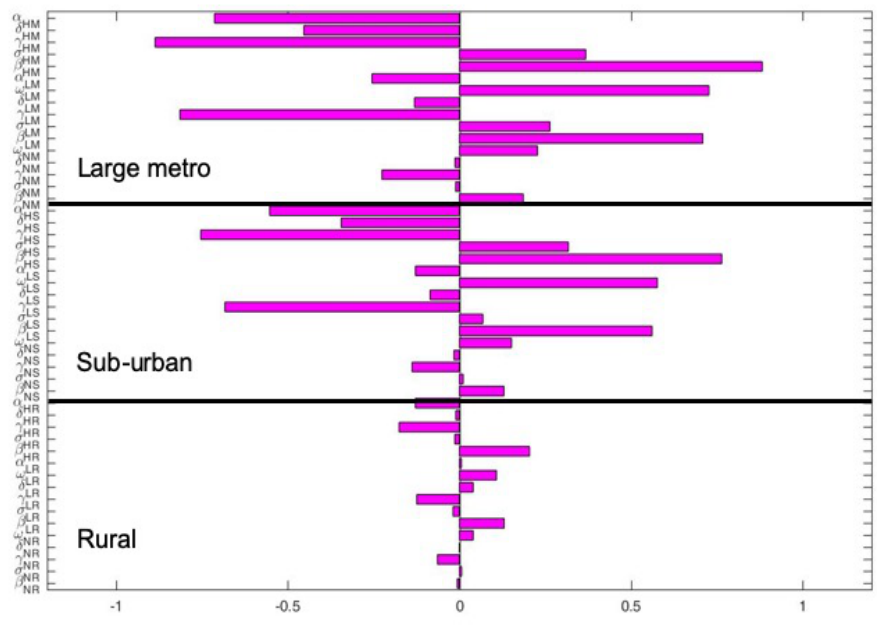
Figure 6. Partial rank correlation coefficient (PRCC) values of the MRSA model using as response function infected individuals when the regions (metro, suburban, and rural areas) are connected. Parameter values used are given in Tables